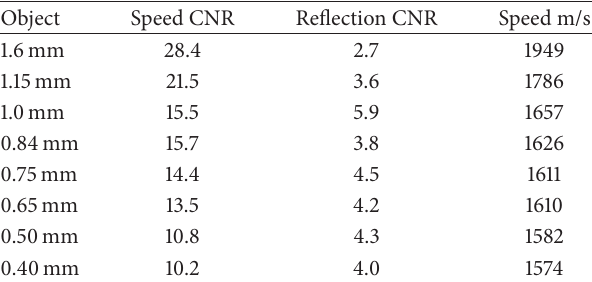
Figure 11: Contrast resolution speed results window leveled to highlight maximum available contrast. Table 4: Speed and reflection